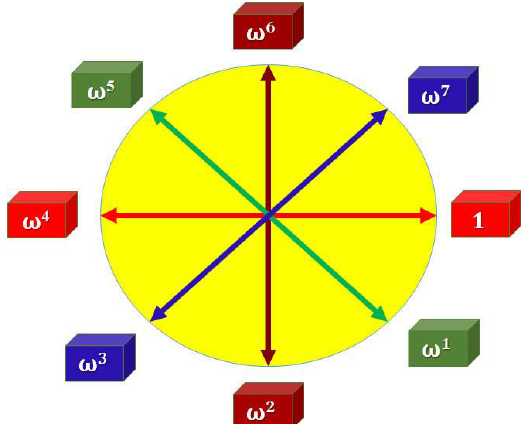
. Figure A2 ω is symmetric, 8th roots of